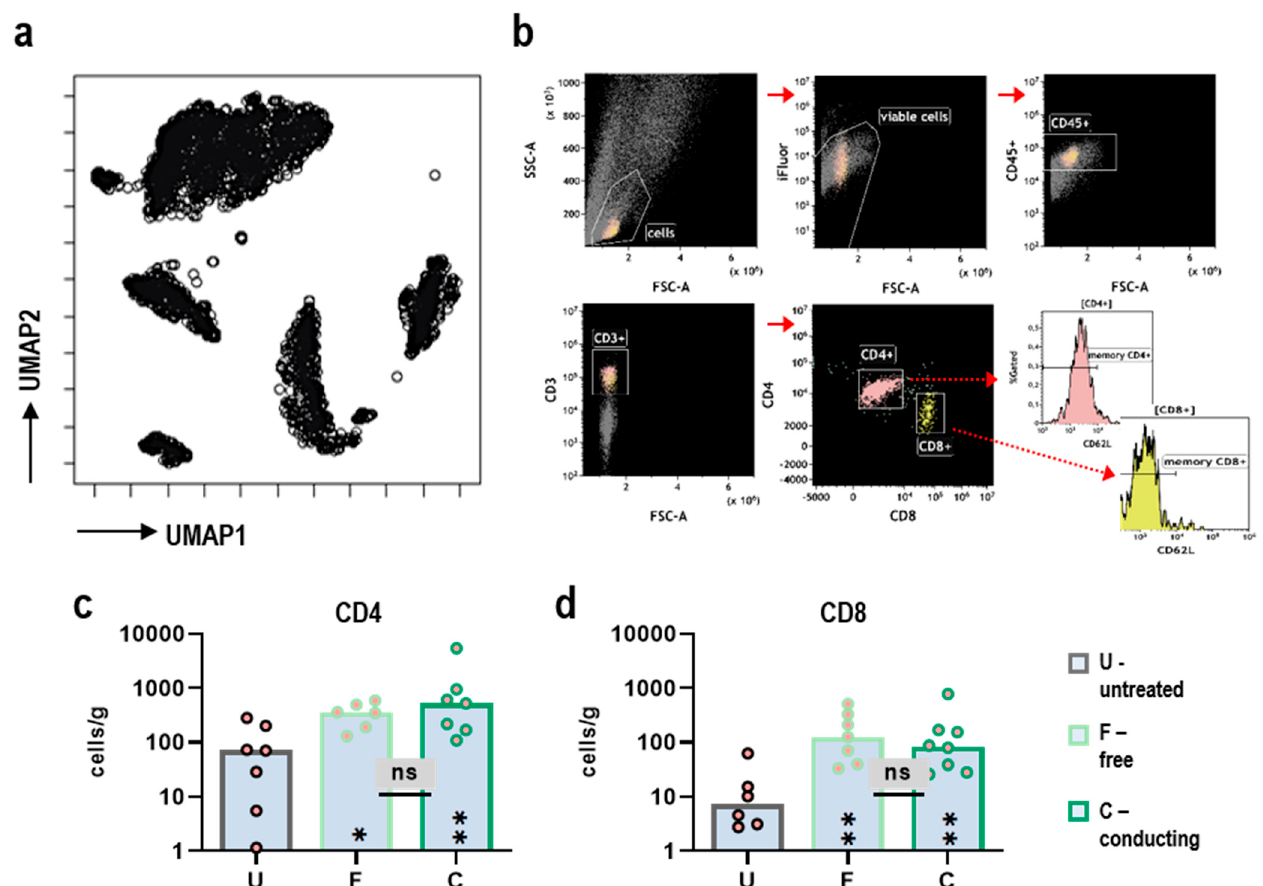
Figure 3. Conducting and free gas plasma treatment equally enhances the infiltration of lymphocytes into tumor tissues in vivo. ( a ) UMAP analysis of CD45 + leucocytes in dissociated tumor nodules; ( b ) flow cytometry gating strategy to investigate the infiltration of CD4 + and CD8 + T cells into dissociated tumor nodules; ( c ) the number of CD4 + T cells per gram of tumor tissue; ( d ) the number of CD8 + T cells per gram of tumor tissue. Bar graphs show medians and individual values. Statistical analysis was conducted using Kruskal–Wallis test and Dunn’s post hoc testing (* p < 0.05, ** p < 0.01). ns = nonsignificant; U = untreated; F = free mode; C = conducting mode.